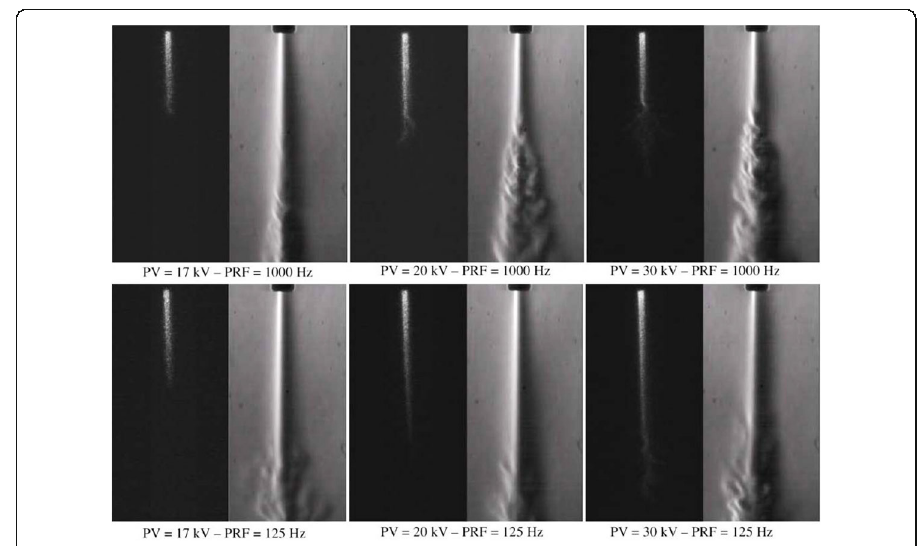
Fig. 2 Comparison of synchronized ICCD (left) and schlieren (right) images of a helium APPJ for different values of peak voltage (PV) and pulse repetition frequency (PRF). Flow rate set at 3 SLPM of He for all cases [54] © 2015 IEEE. Reprinted, with permission, from IEEE Transactions on Plasma